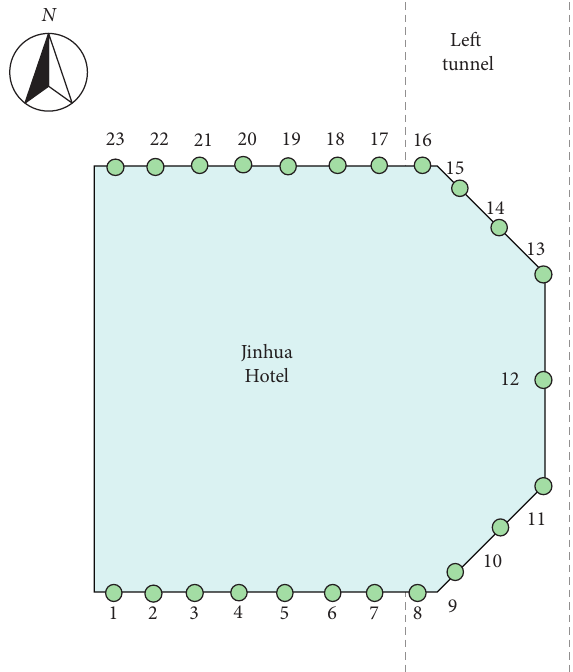
Figure 14: Building subsidence monitoring points.